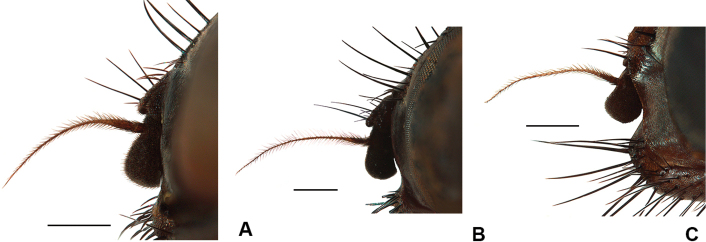
Female arista AD.
huckettiBD.
aterrimaCD.
minor. Scale bars: 0.25 mm.